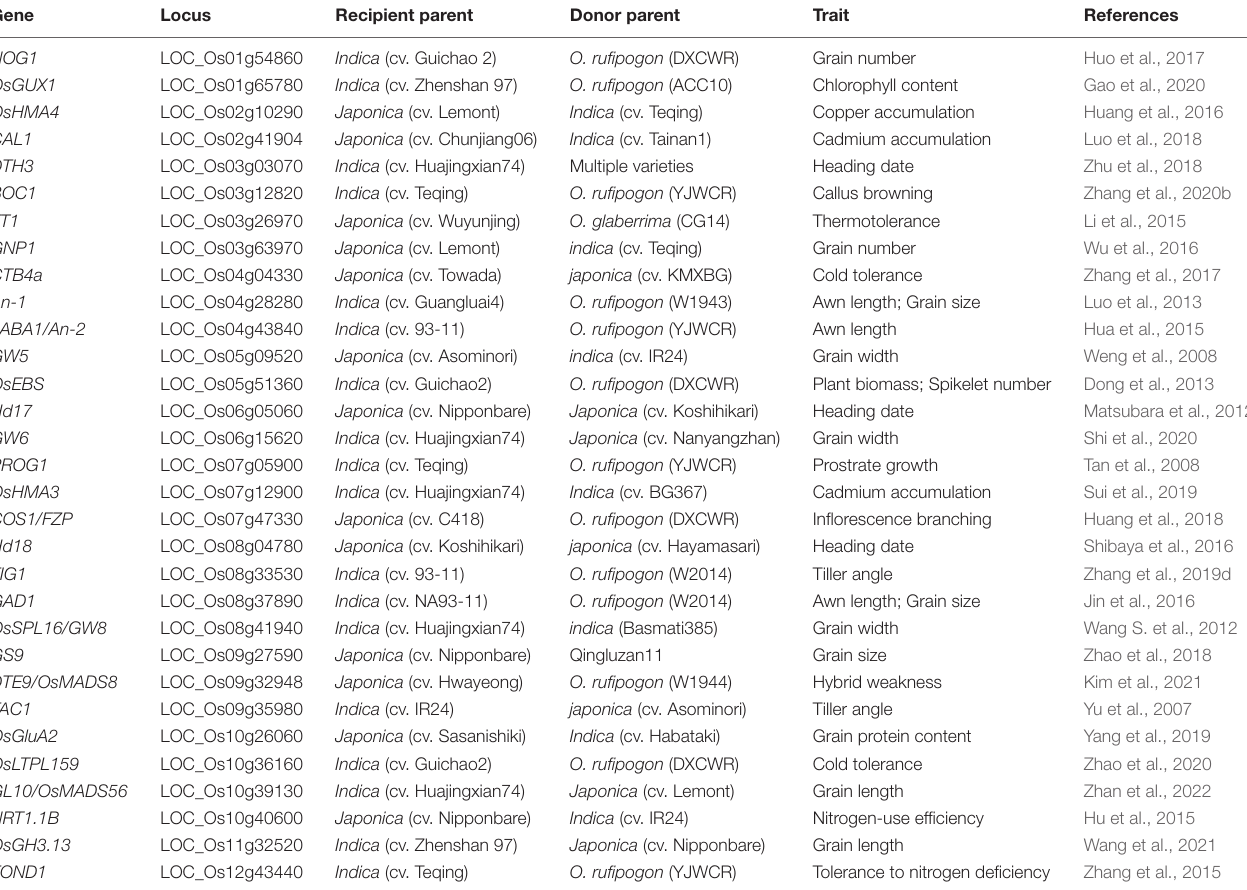
TABLE 2 | List of genes with natural variations identified by ILs and cloned by IL-derived populations in rice. Gene